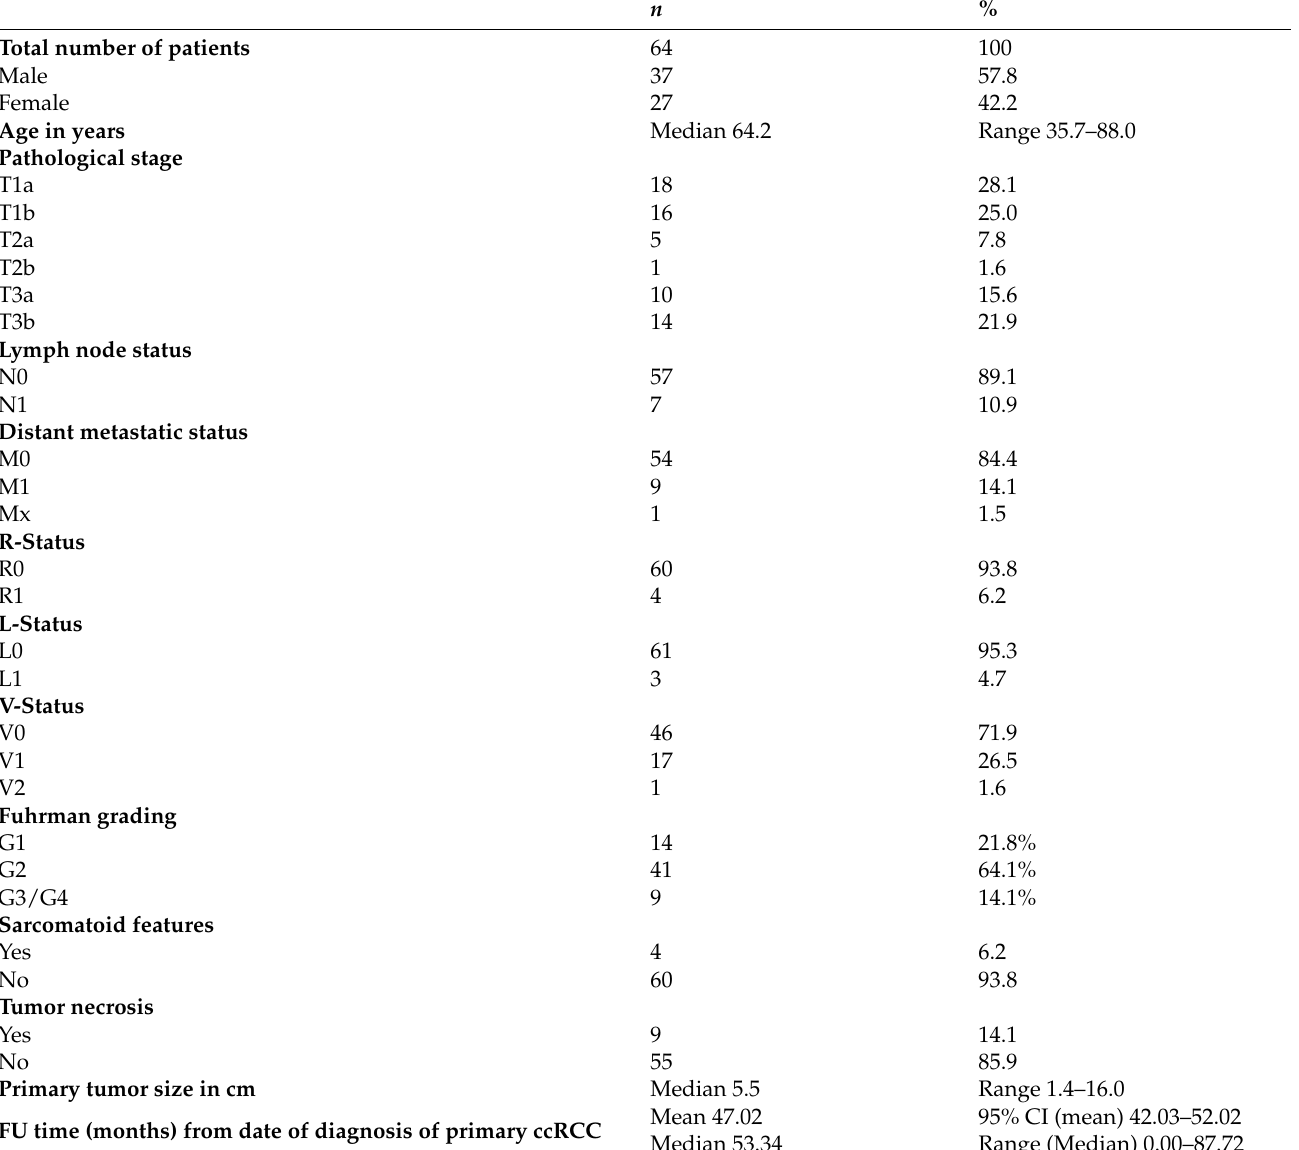
Table 1. Characteristics of patient cohort n 1 : primary tumor